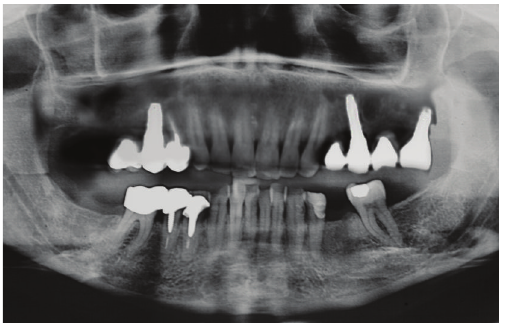
Figure 9: Panoramic X-ray after the